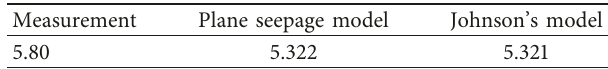
Table 4: Settlement of the elastic model (mm).